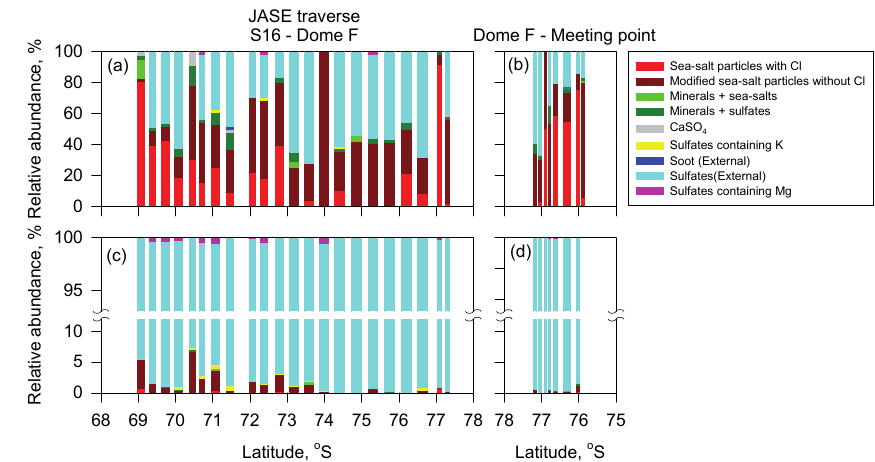
Figure 8. Horizontal features of relative abundance of each aerosol constituent in (a–b) coarse and (c–d) fine modes during the incoming